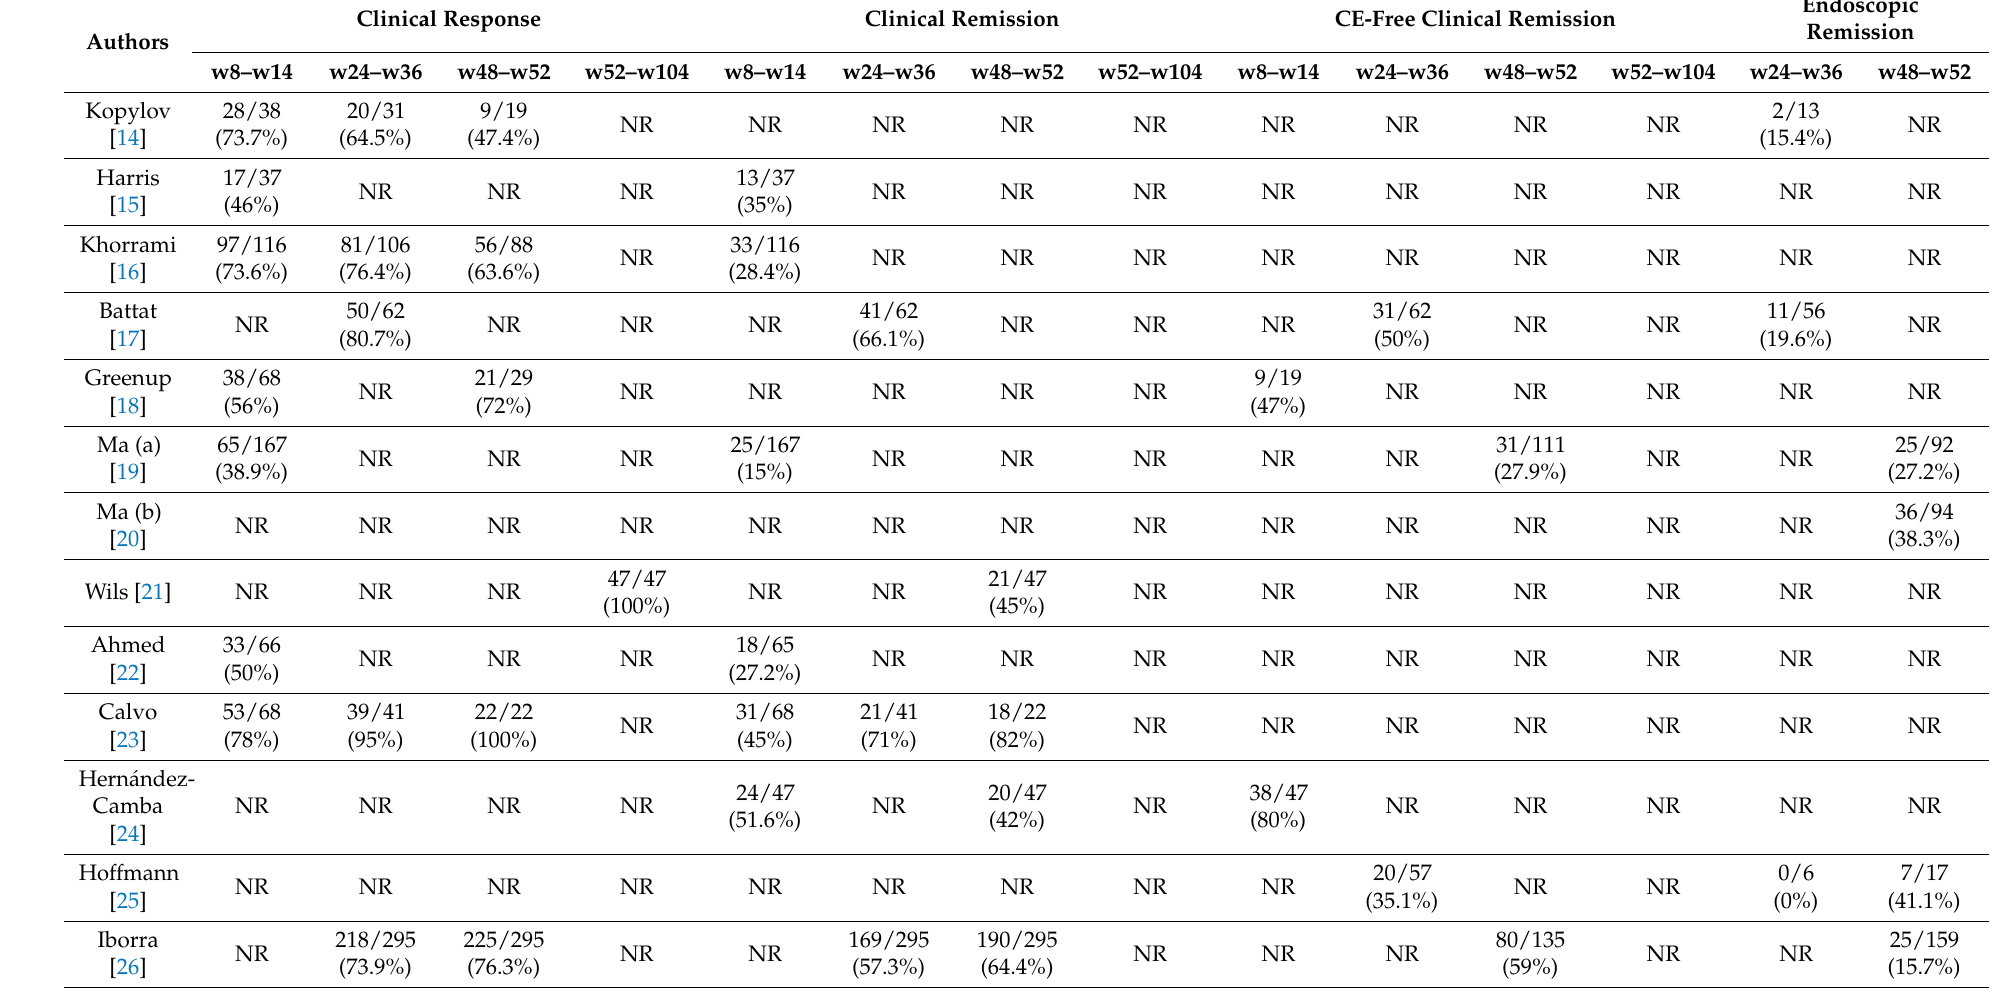
Table 2. Effectiveness of